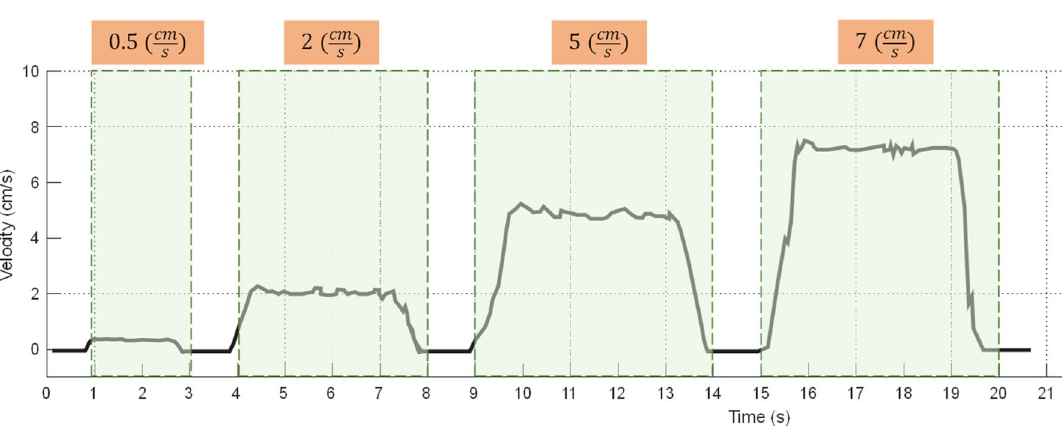
Figure 11. Results of Leap motion